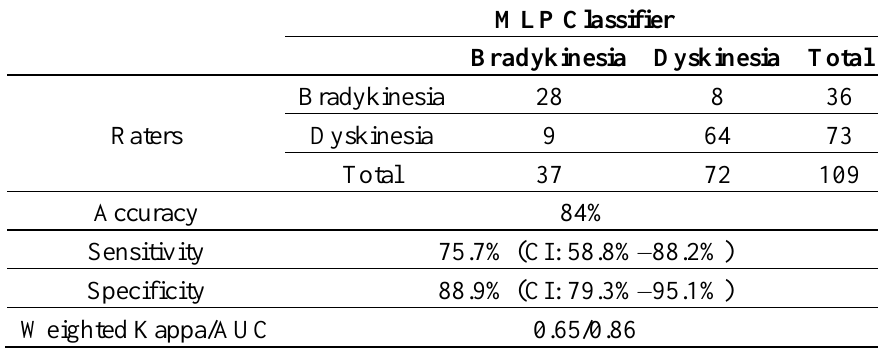
Table 5. Assessments of motor symptoms for the multilayer perceptron (MLP)